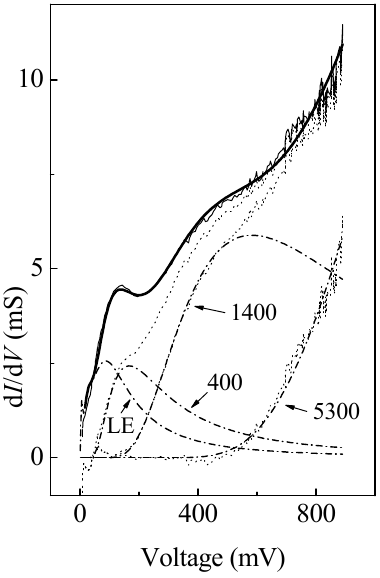
Figure 6. The averaged experimental G(V) curve (thin solid line [32]) and its description (thick solid line) by the sum of the elementary terms with δ E i = 5, 16, 80, 260, 400, 1400, and 5300 meV. The dash-dotted lines are the low-energy (LE) part of the spectrum and additional terms. The dotted lines are residuals after subtraction of the calculated curves. The results of the analysis using Equation (7) are shown as dash-dotted lines in Figure 6. Additional elementary terms with the characteristic energies δ E i = 400, 1400, and 5300 meV are detected. The procedure of their separation is similar to that described above. The only explanation that needs to be done relates to accounting the low-energy part of the spectrum in order to obtain a residual. The averaged curve in this part of the spectrum is strongly smoothed but is due seemingly to the same elementary terms as the above local curve. In view of this circumstance, to approximate the low-energy part of the spectrum at V < 70 meV, we used the entire set of “local” characteristic energies in the form of the LE contribution. This is the reason why the “high energy” residual shown by the dotted line in Figure 6 exhibits “dips” near V = 0. This does not affect the approximation of the high-energy residual of the averaged curve and this entire curve by the set of elementary terms (Equation (7)) with the characteristic energy gaps δ E i = 5, 16, 80, 260, 400, 1400, and 5300 meV. The latter is shown by a thick solid line in Figure 6. One may think that such a large number of gaps were used solely for the purpose of a qualitative fit. However, this is not exactly so.